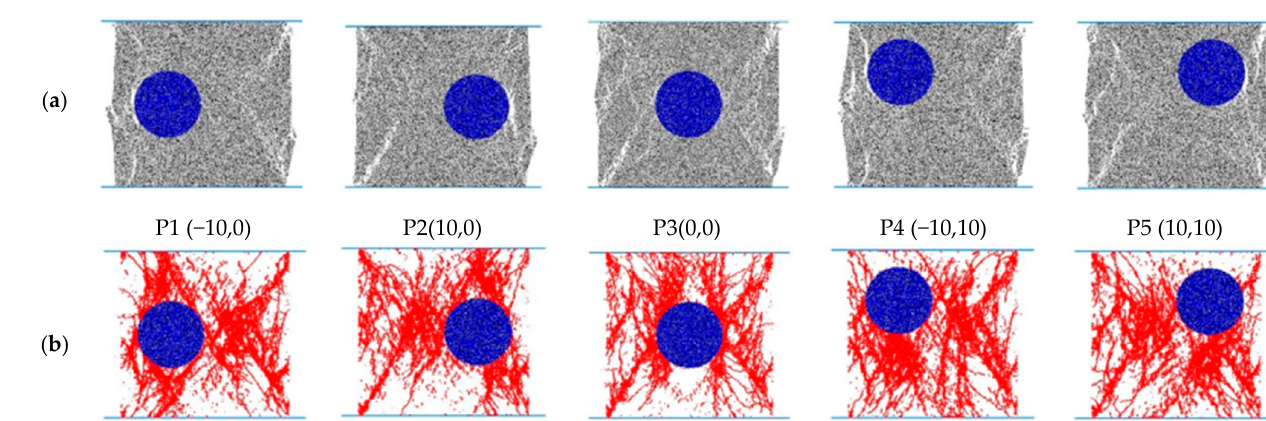
Figure 9. Typical failure modes of specimens in Group 3: ( a ) failure mode of specimen; ( b ) failure mode of concretion.